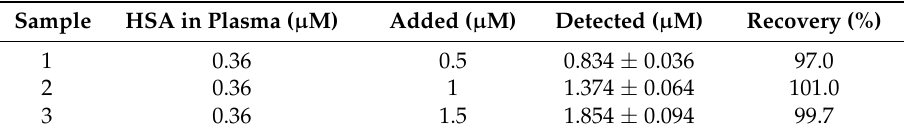
Table 1. Recovery of HSA in diluted human serum using the proposed